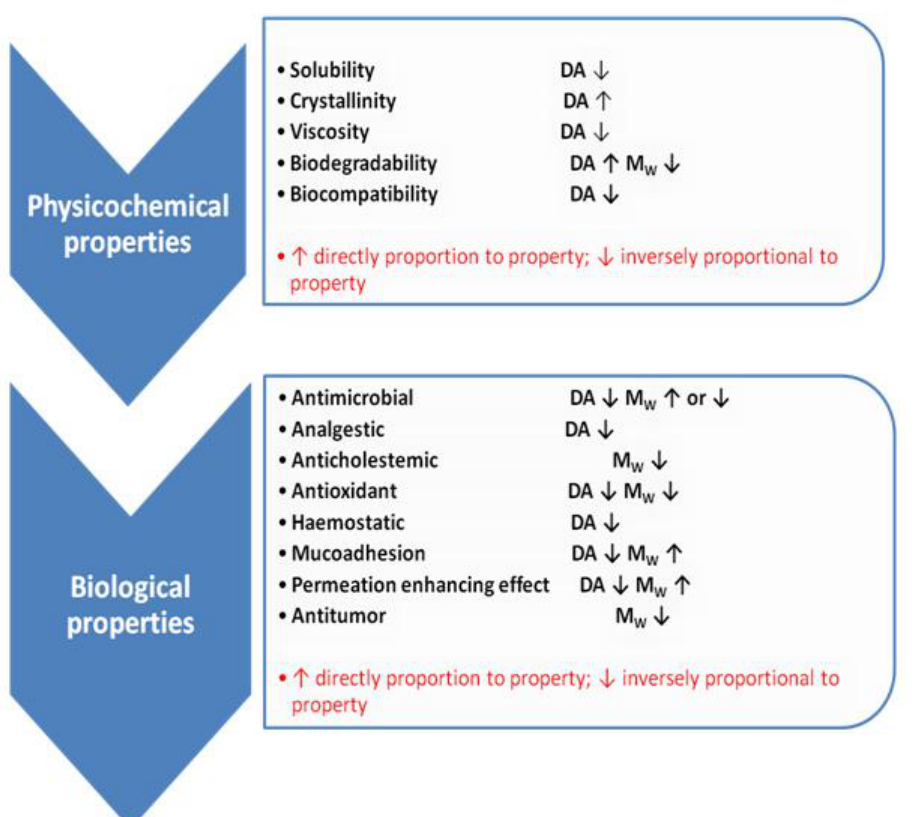
Figure 3. Influence of degree of N -acetylation (DA) and molecular weight (M physicochemical and biological properties of chitin/chitosan